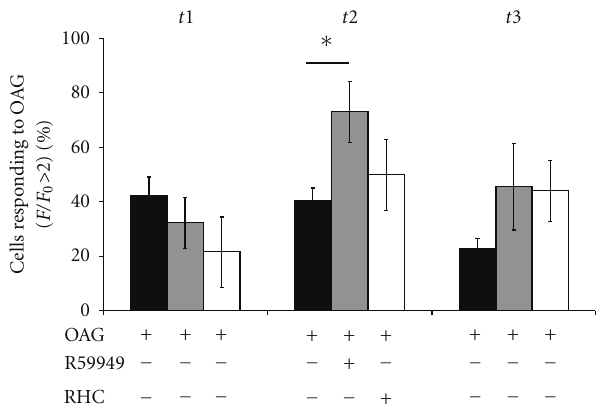
Figure 3: Blockade of DAG metabolites does not inhibit astrocytic ATP release. Inhibition of DAG kinase with 10 µ M R59945 causes an increase in astrocytic calcium oscillations in response to 30 µ M OAG (control n = 13, R 5 n = 5; P = 0 . 016). Inhibition of DAG lipase with 50 µ M RHC80267 had no e ff ect on astrocyte ATP release (control n = 6, RHC = 9; P = 0 .